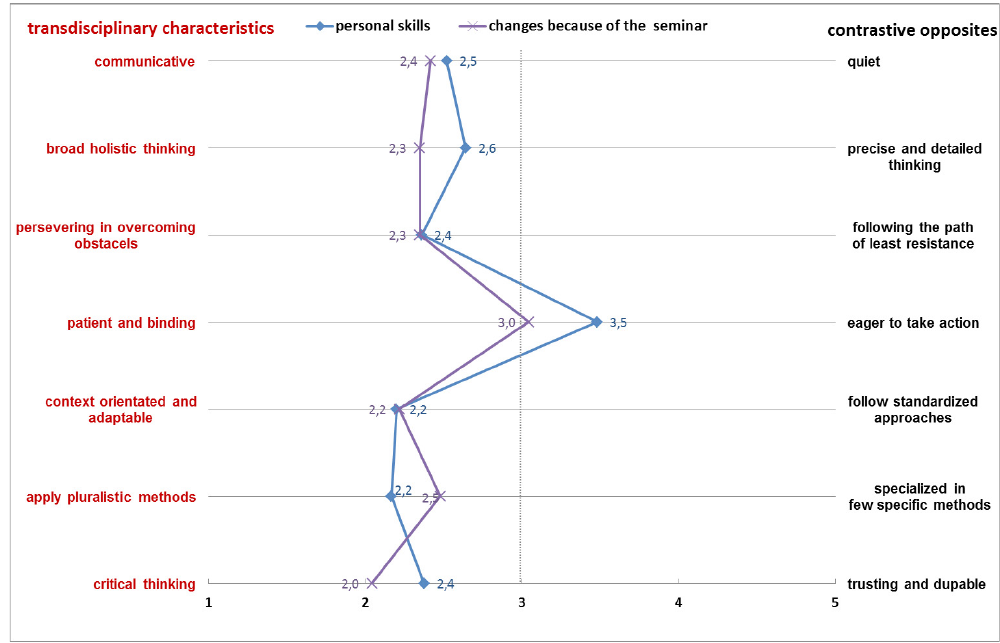
Figure 1: Semantic differential on transdisciplinary